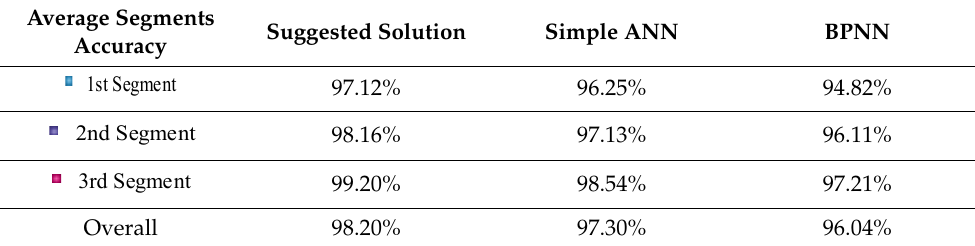
Table 5. Comparative analysis under the different noisy event.